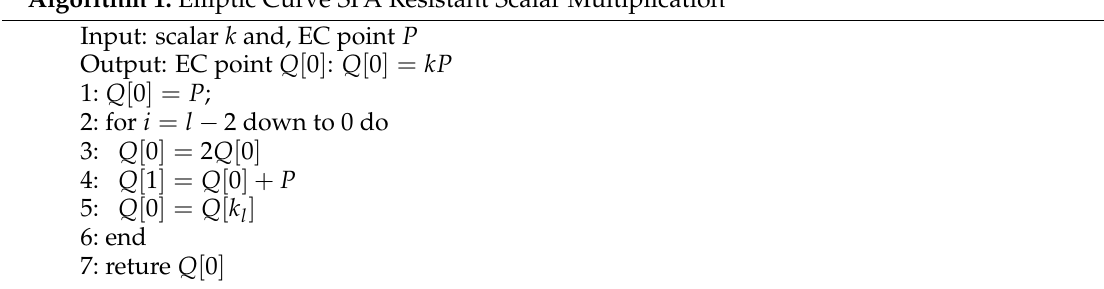
Algorithm 1: Elliptic Curve SPA Resistant Scalar Multiplication